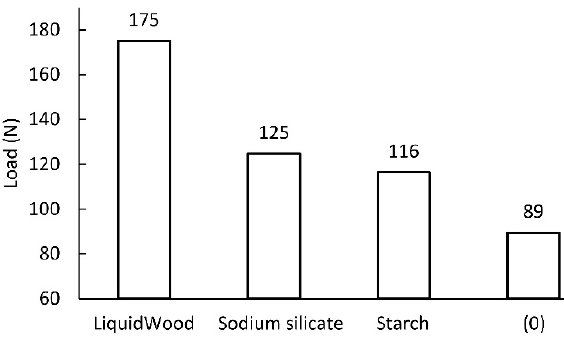
Figure 5. Tensile strength of paper impregnated with an aqueous solution of sodium silicate of varying concentration. Unimpregnated paper marked by 0% concentration.